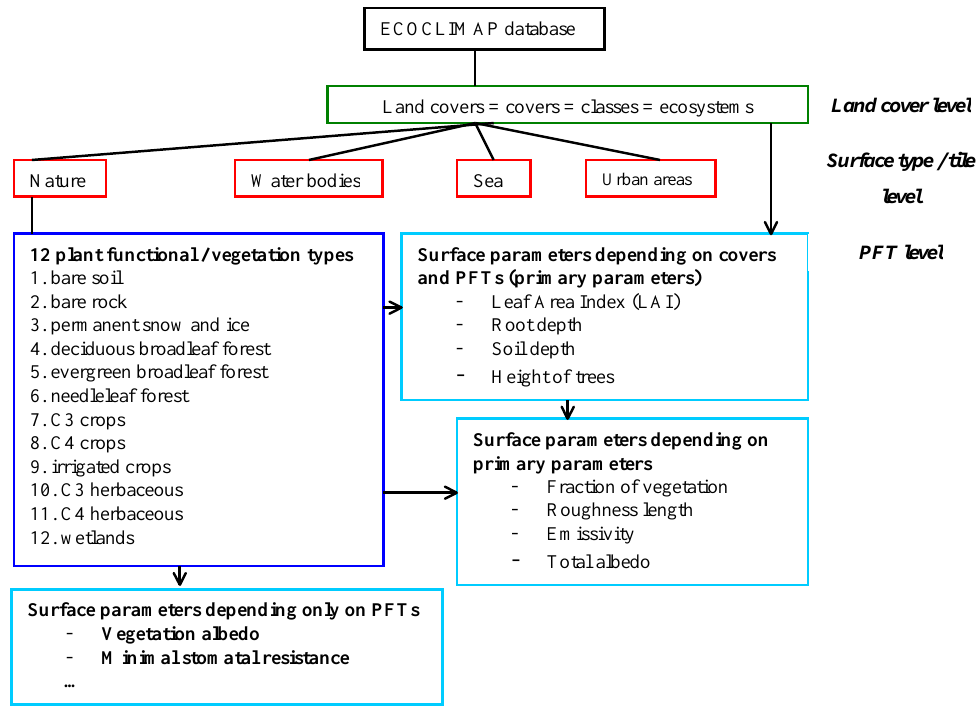
Fig. 1. Organization of ECOCLIMAP Figure 1. Organization of ECOCLIMAP database